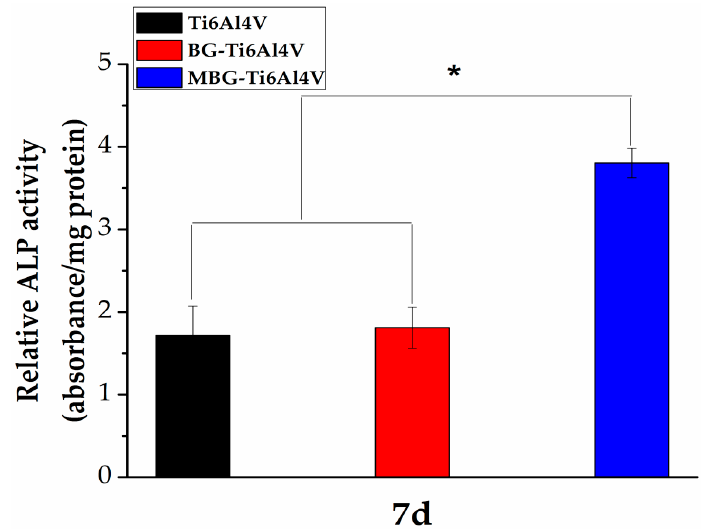
Figure 9. Osteogenesis-related gene expression ALP of hBMSCs after culturing with the three groups of scaffolds on day 7 (* p < 0.05, significant difference compared to the blank control).